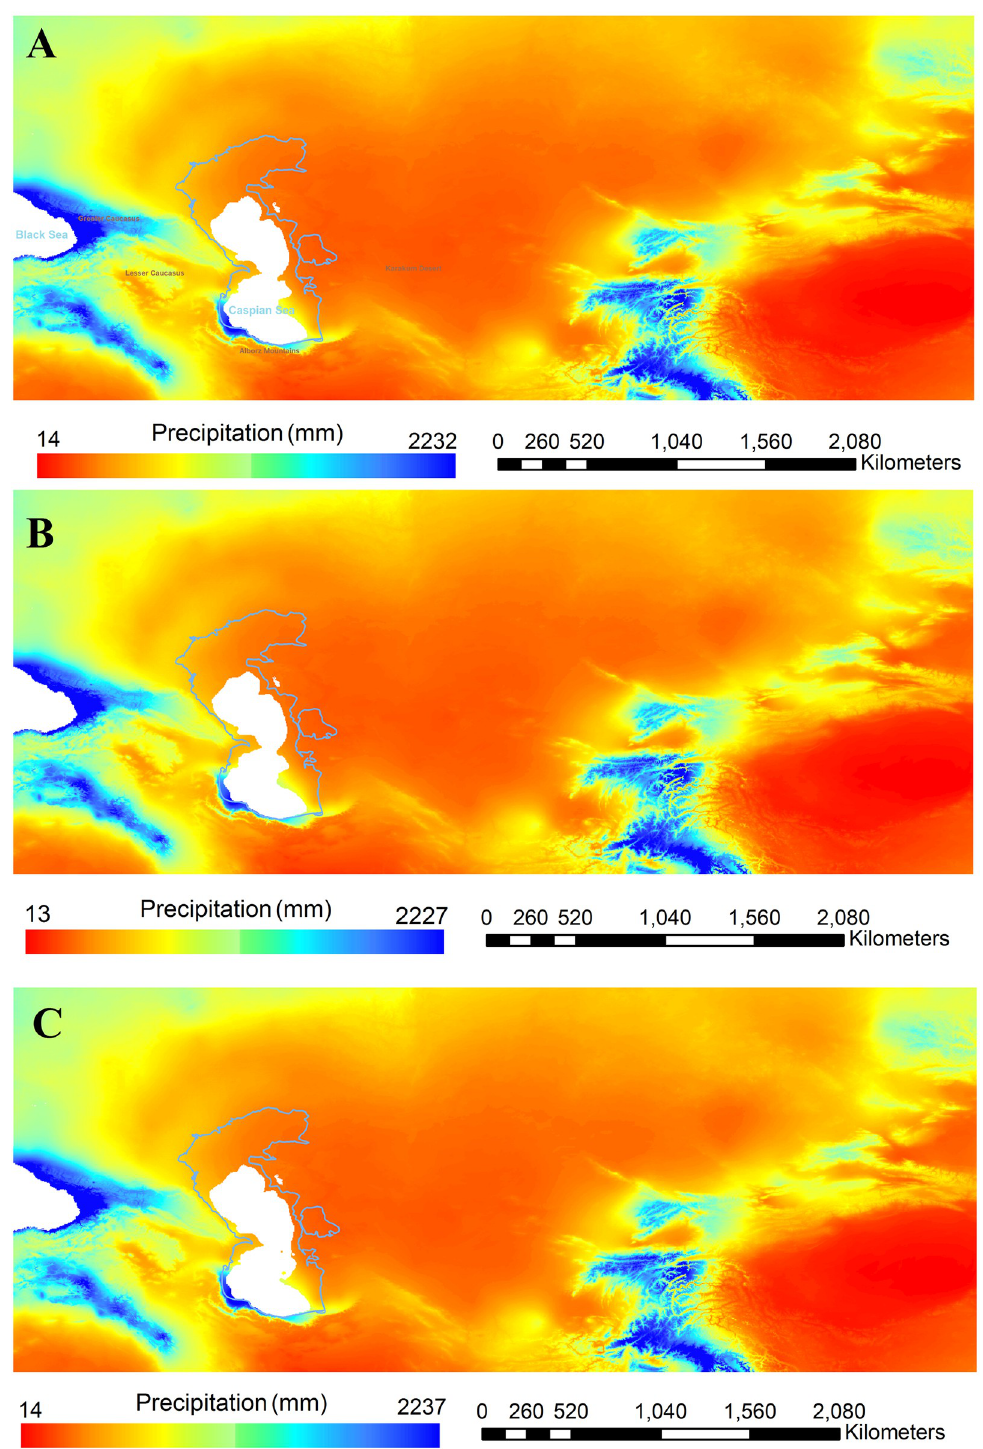
Fig 5. Reconstruction of spatial variations of annual precipitation during MIS 4. A: 50 ka, B: 60 ka, C: 70 ka (maps created based on Oscillayers dataset 68 ).